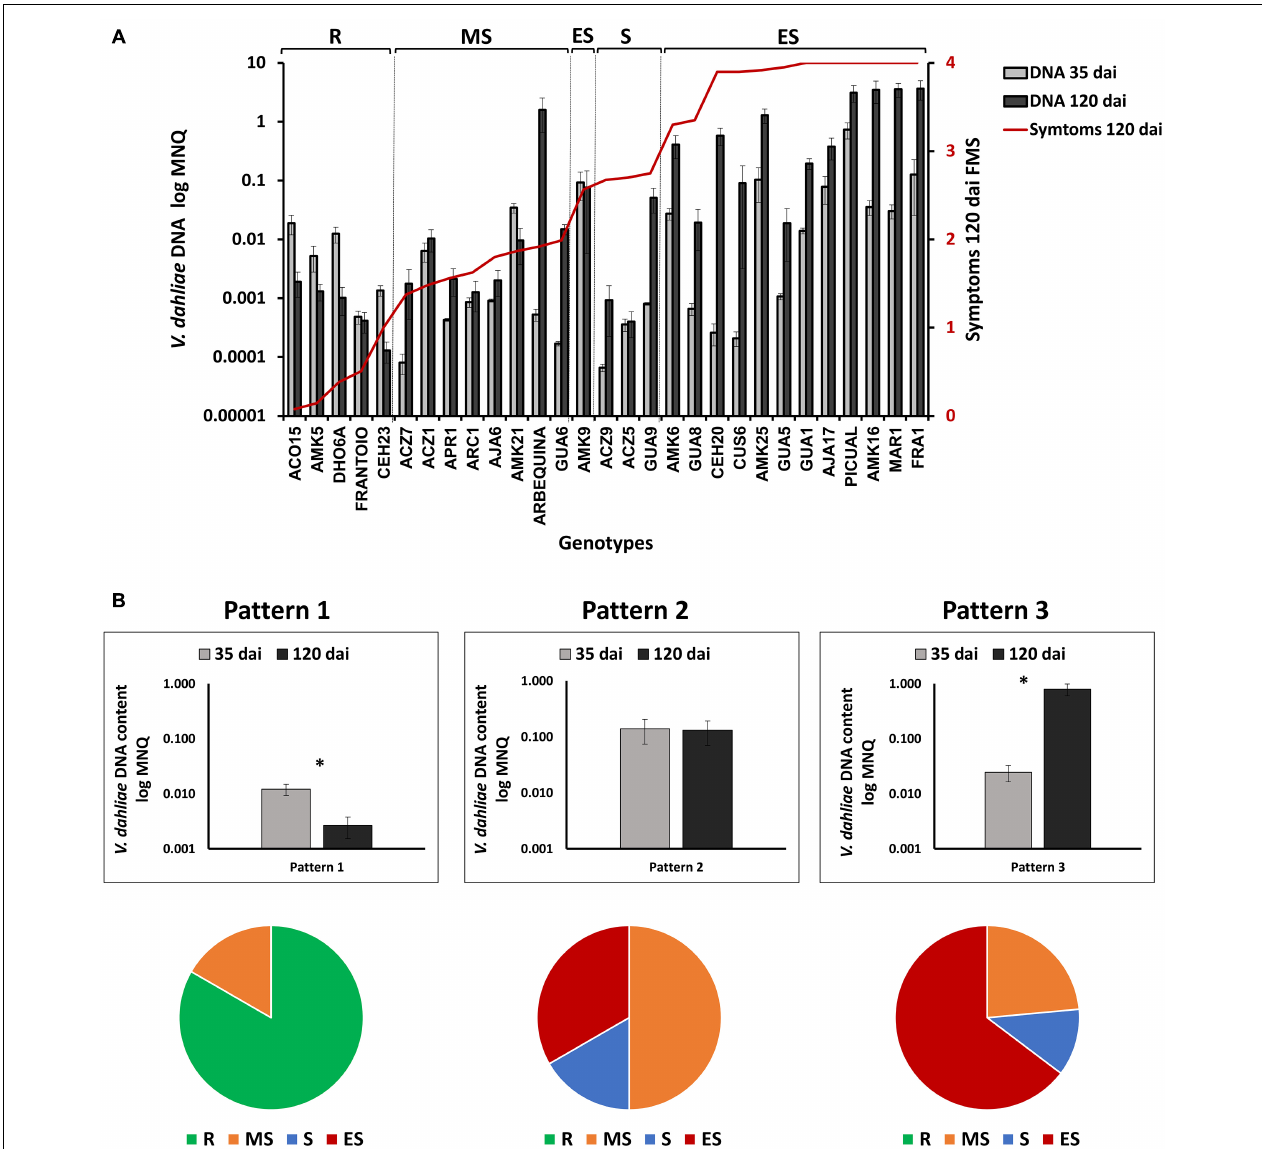
FIGURE 6 | (A) Evolution of Verticillium dahliae content after inoculation in genotypes tested in assays 1, 2, and 3 (A) Quantification of V. dahliae DNA (Mean Normalized Quantity, MNQ) in wild olive genotypes inoculated with the defoliating isolate VD117 of V. dahliae at 35 and 120 days after inoculation (dai). Bars represent the mean of 12 plants per assay, or 24 plants for those genotypes repeated in two different assays. The red line represents the average final mean severity (FMS) at 120 dai for each genotype. (B) Patterns of variation of V. dahliae DNA quantity between 35 and 120 dai (upper diagram), and relative content of genotypes according to the resistance level described by López-Escudero et al., 2007; lower diagram) for each pattern. Asterisks indicate significant differences at P < 0.05. The data were subjected to analysis of variance (ANOVA) and multiple comparisons of means were analyzed by Tukey’s HSD (Honestly significant difference). Error bars represent the standard error of the mean. R, resistant; MS, moderately susceptible; S, susceptible; ES, extremely